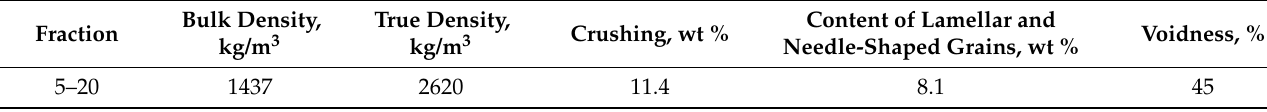
Table 2. Physical and mechanical characteristics of crushed granite.